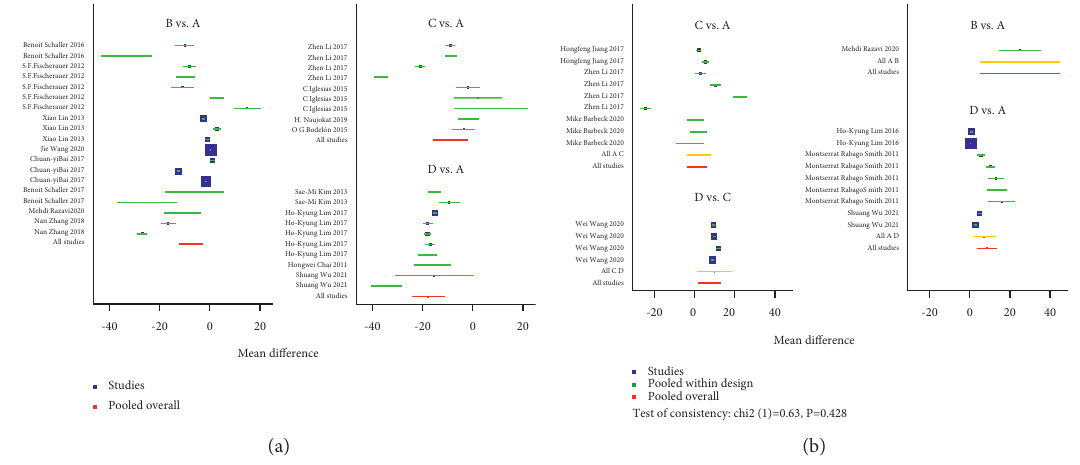
Figure 10: Forest plots for all comparisons: (a) % degradation and (b) new bone formation. A, BM; B, MAO-coated Mg; C, FLU-coated Mg; D, Ca-P-coated Mg.